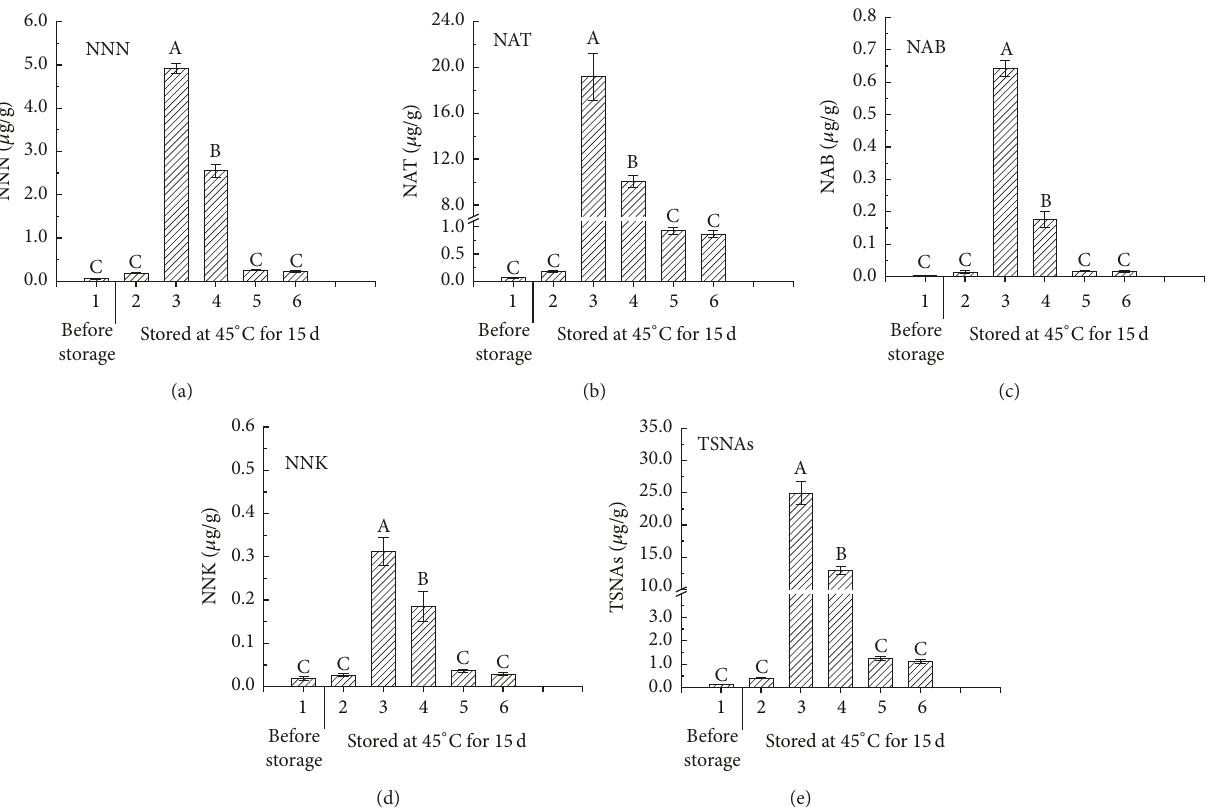
Figure 8: Effect of activated carbon (AC) on TSNAs formation in flue-cured tobacco in response to nitrite addition. Note . (1) tobacco (before storage, 4 ∘ C), (2) tobacco, (3) tobacco + NaNO 2 , (4) tobacco + NaNO 2 + AC 1.0 g, (5) tobacco + NaNO 2 + AC 5.0 g, and (6) tobacco + NaNO 2 + AC 10.0g, 20 g of flue-cured tobacco, and 0.3 g NaNO 2 (200mg of NO 2− ). The NO 2− , AC, and tobacco were added separately in the vacuum desiccators stored at 45 ∘ C for 15 d. Uppercase letters indicate significant differences between the treatments at 𝑃 < 0.05